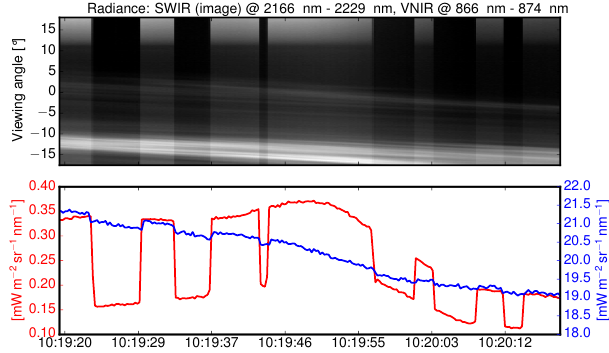
Figure 3. The top image shows a zenith pointing scene as captured with the SWIR camera. During the capture, stray light has been repeatedly shielded from the sensors with a prototype of the now permanently installed stray light protection. Due to the faint cloud cover, the radiance from inside the nominal field of view is very small and the stray light effect becomes very obvious. The lower plot shows the radiance averaged over the full field of view of the SWIR and VNIR sensors in red and blue respectively. On both sen- sors, a stray light effect and its mitigation is visible, however the effect on the VNIR is much less pronounced. This can be under- stood due to the brighter background illumination as well as due to less reflective fore optics of the sensor.